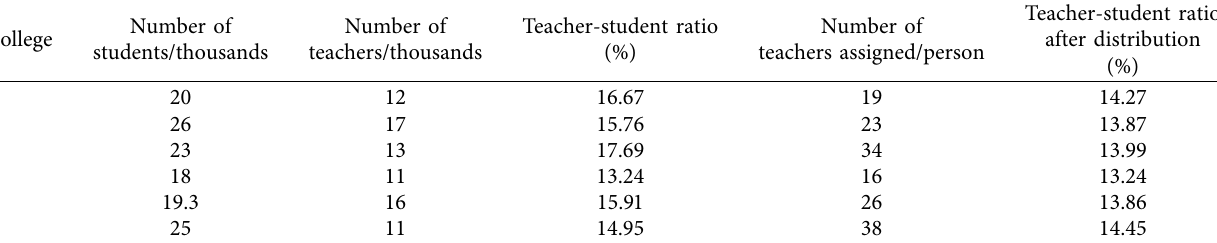
Table 5: Resource confguration.